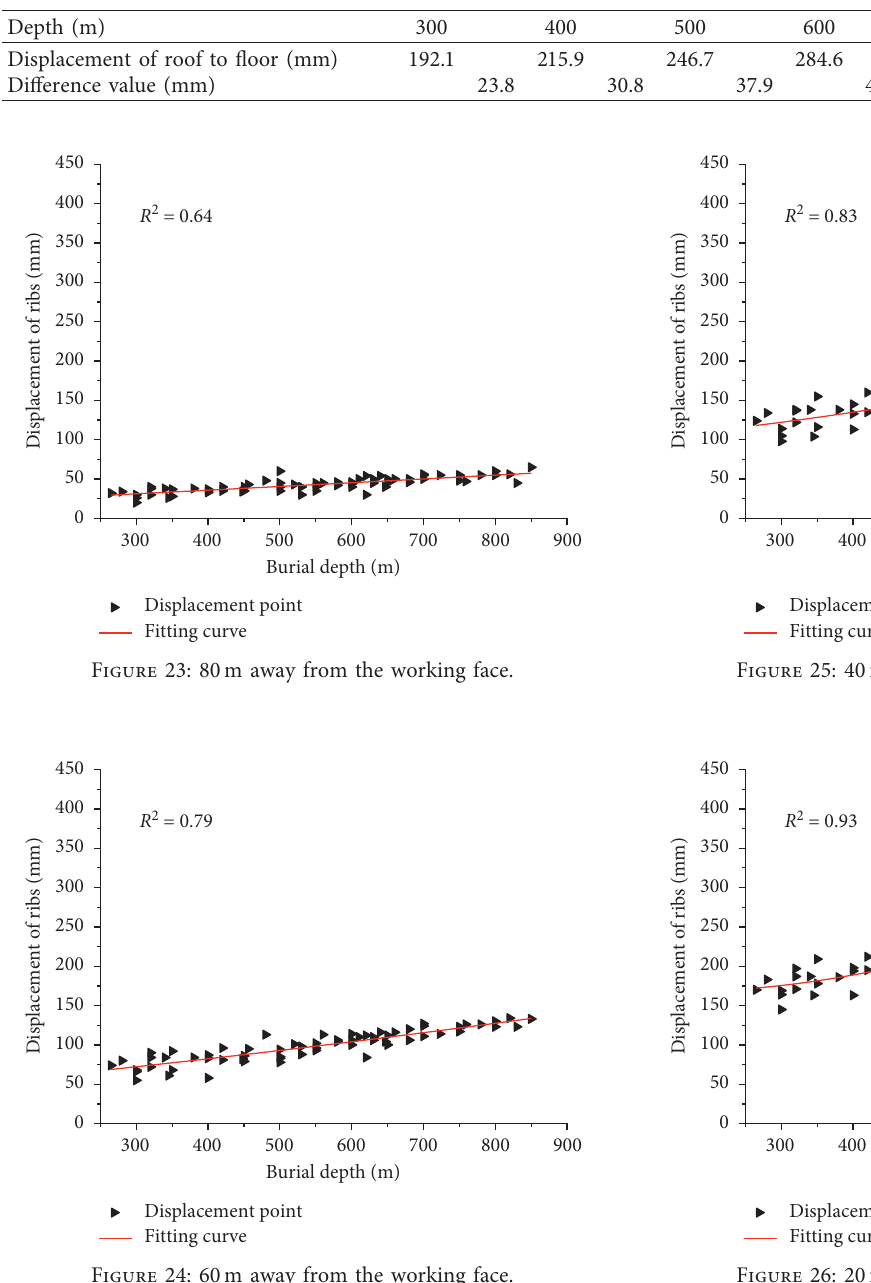
Table 3: Comparison of the final displacement of mining roadway roof to floor.